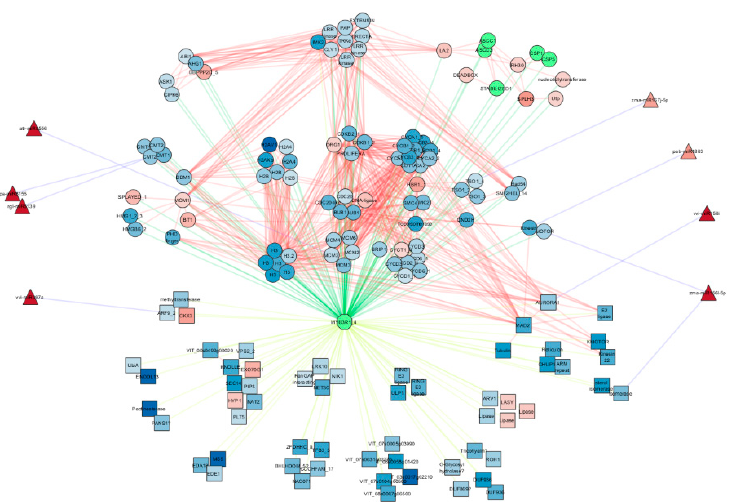
Figure 4. Protein network of MYB3R1 interaction with transcriptional targets (squares), protein interactors (circles), and miRNA (triangles). Transcriptional target, protein interactors, and miRNA nodes are represented by squares, circles, and triangles, respectively. MYB3R1-target interactions are denoted by yellow edges, MYB3R1-protein interactions by green edges, protein-protein interactions by red edges, and miRNA-target by blue edges. The node fill color (blue (negative) to red (positive)) indicates the log fold change expression values for differentially expressed genes and nodes with green fill color were not differentially expressed in SD relative to LD buds (Table S9).